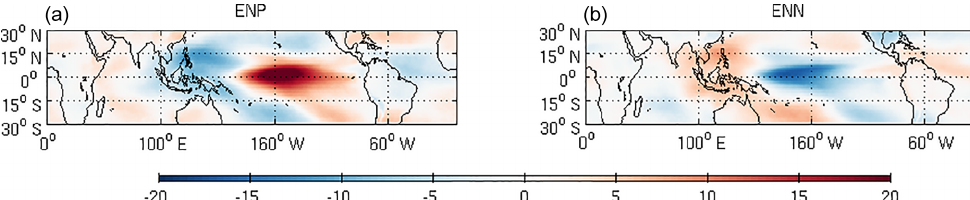
Figure 9. Ensemble model mean of simulated total cloud fraction anomalies (%) as a response to the positive phase of ENSO (a) and negative phase of ENSO (b)